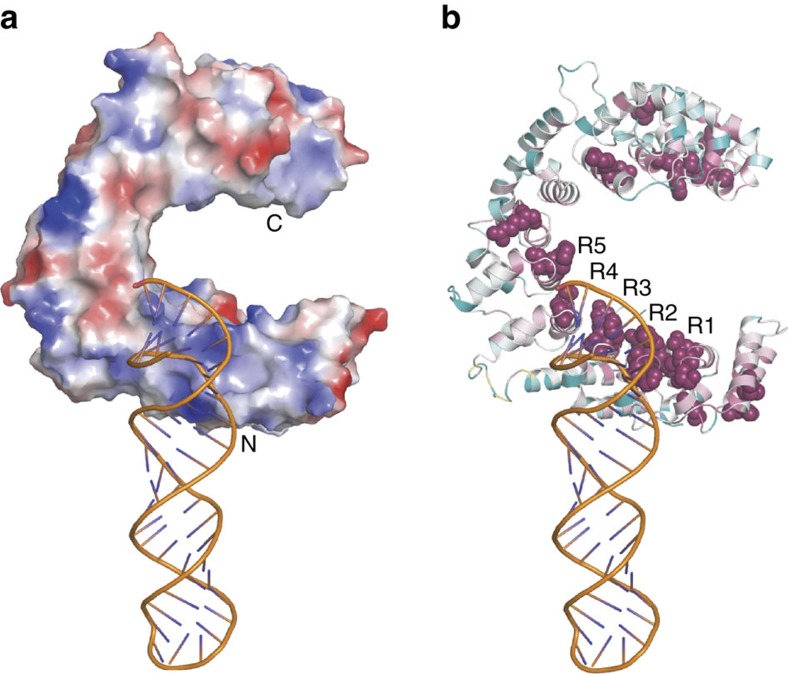
SAXS model of the Nop9 protein and ITS1 D-A2 subdomain A pre-rRNA.(a) Rigid body SAXS model of the Nop9:ITS1 D-A2 subdomain A pre-rRNA complex. The crystal structure of Nop9 and a predicted model of the ITS1 D-A2 Subdomain A pre-rRNA from SAXS data of the RNA alone are shown. Positively and negatively charged surfaces are shown in blue and red, respectively. The vacuum electrostatic surface potential was calculated using the APBS module within PyMol. (b) ITS1 D-A2 pre-rRNA contacts the conserved Nop9 repeats. The extent of amino-acid sequence conservation was calculated using the ConSurf server53 with default settings, and the results are displayed on a ribbon diagram of Nop9 (highly conserved residues are coloured maroon and less conserved residues are cyan). The most highly conserved residues are shown with space-filling spheres.